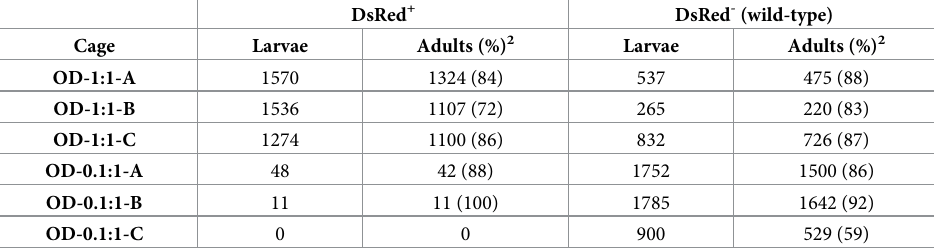
Table 2. Larval to adult survival in overlapping gene drive cage trials 1